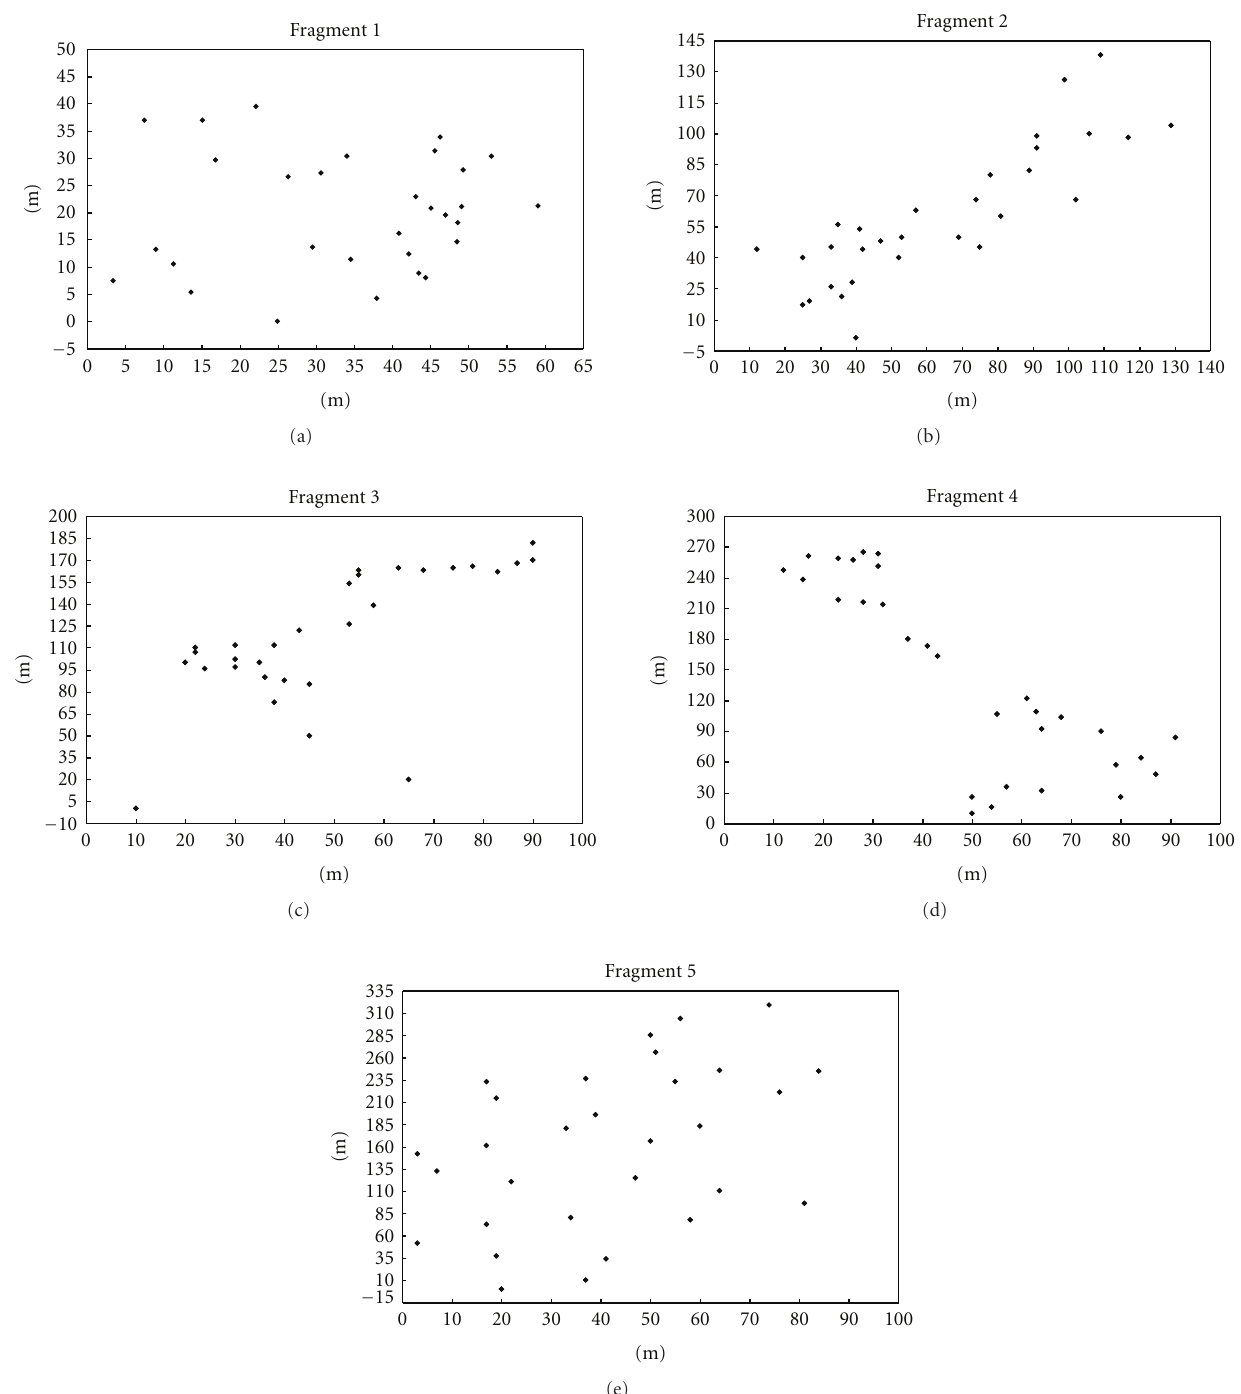
Figure 4: Distribution of the trees sampled in five fragments for the analysis of the fine-scale SGS in Protium spruceanum .